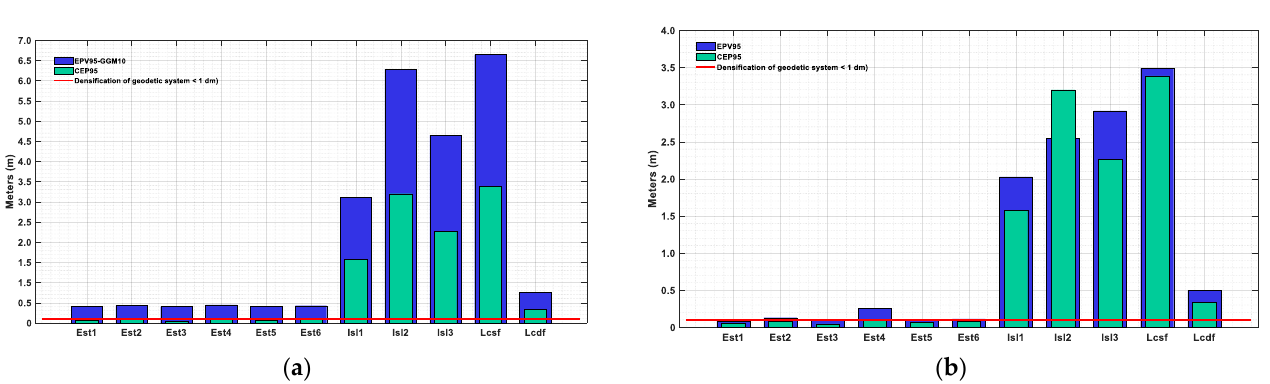
Figure 10. Differences in the CEP and EPV of Precise Point Positioning according to the INEGI technical standard. ( a ) EPV with inclusion of geoidal model GGM10; ( b ) EPV without inclusions of geoidal model GGM10.